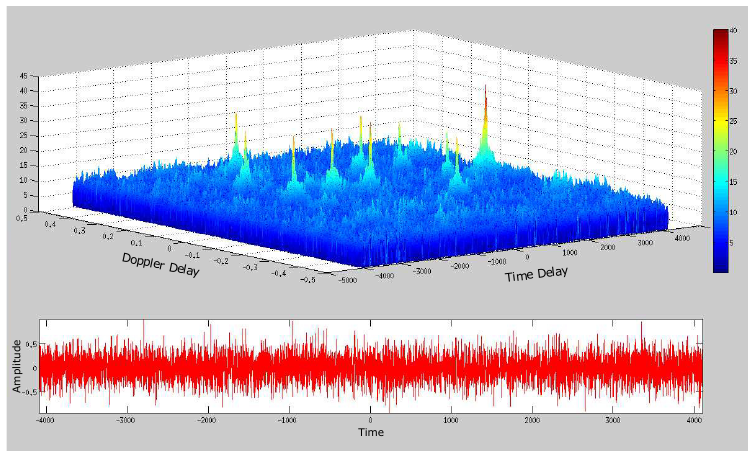
Figure 28. Multiple object tracking using MMPP “chirp pulses”, at Tracking Time 2, with − 5 dB SNR.